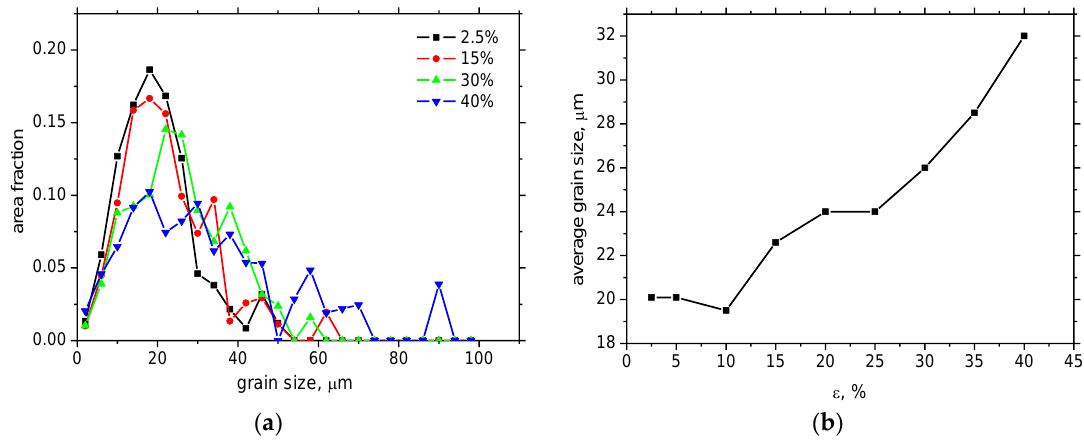
Figure 5. ( a ) Grain size distribution and ( b ) evolution of average grain size as a function of ε . Note that this increase is only related to the significant change in the grain shape, and real grain growth was not observed. The most pronounced increase in the average grain